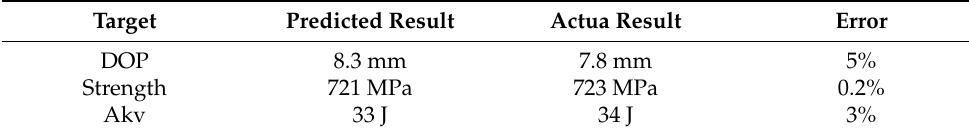
Table 12. Comparison results between model predicted value and actual